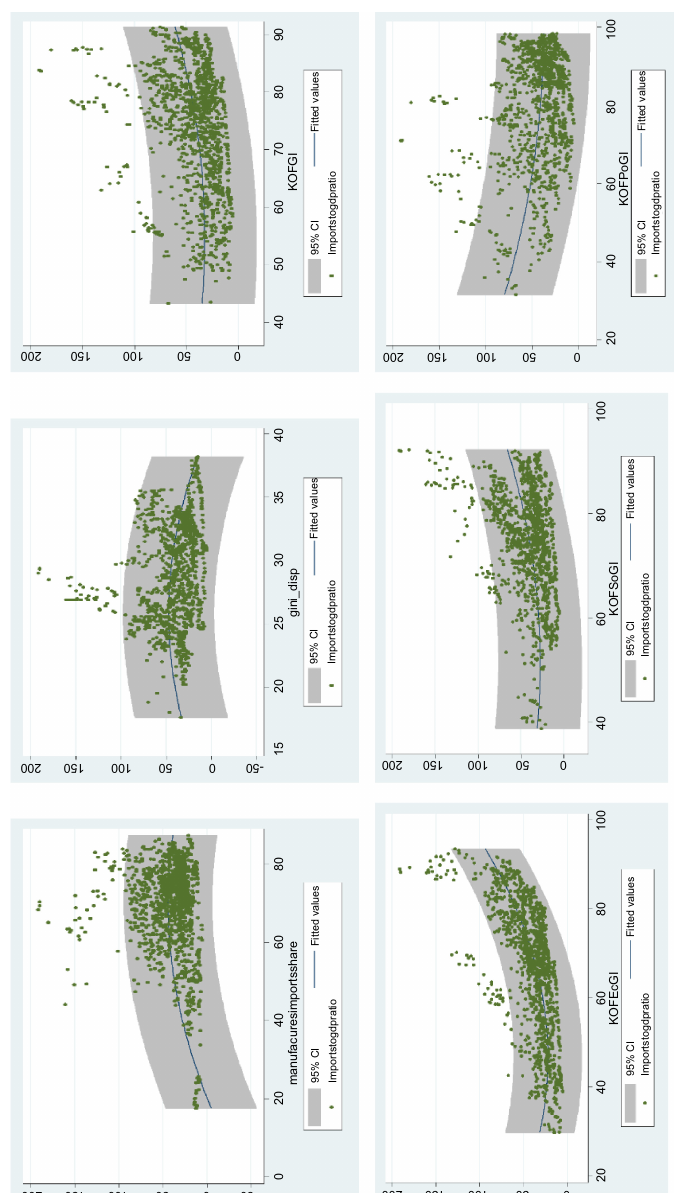
Figure 8. Scatter plots and OLS fitted (developed